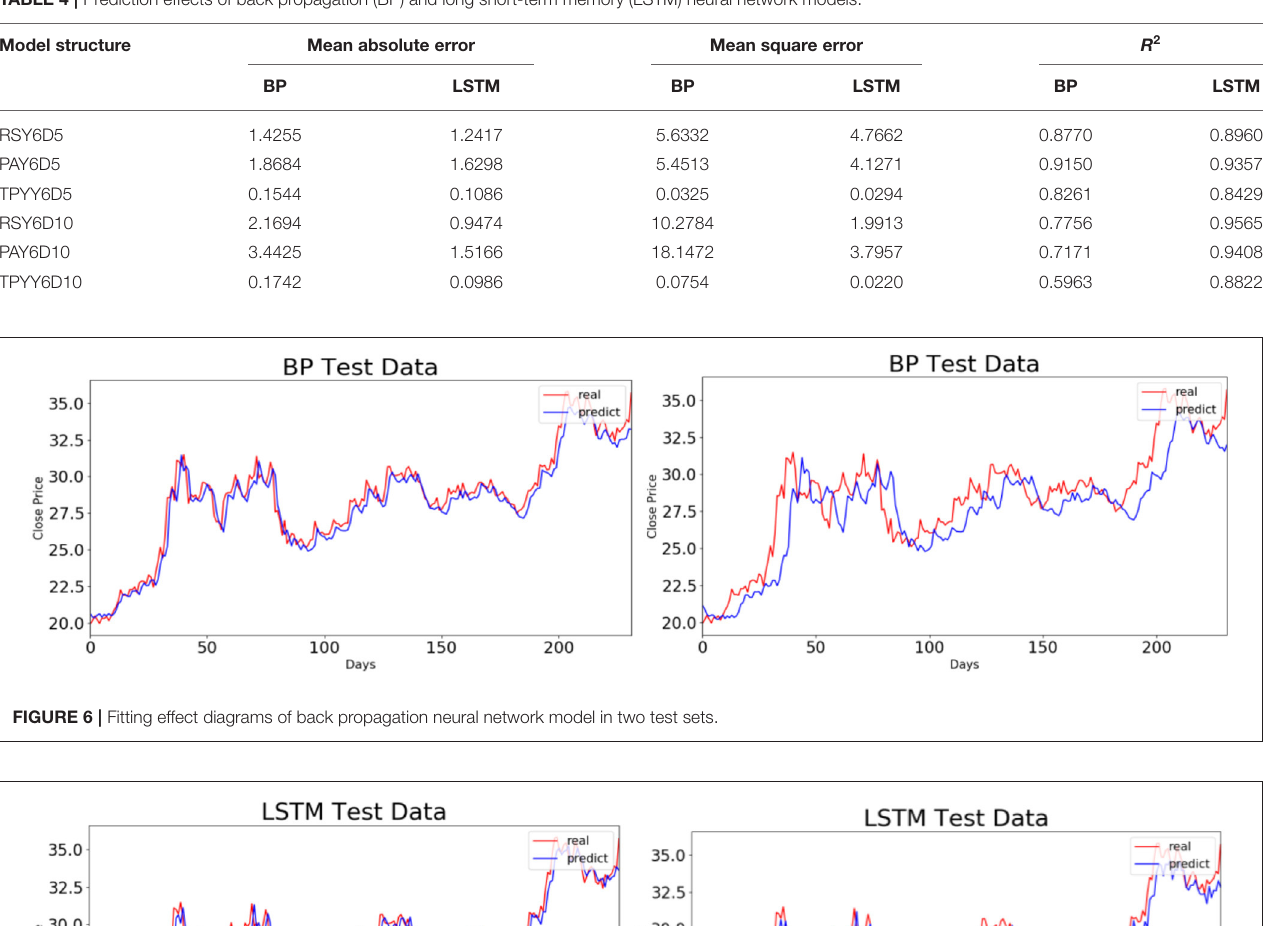
Model structure